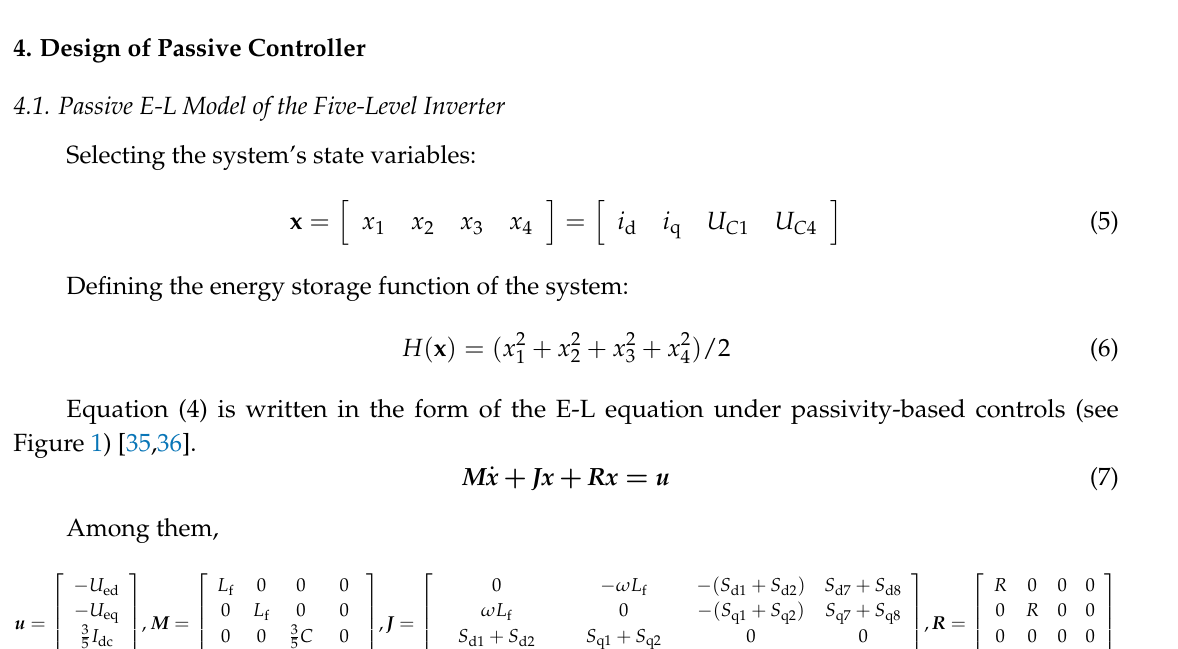
Figure 2. Comparison of modulation wave and carrier wave.